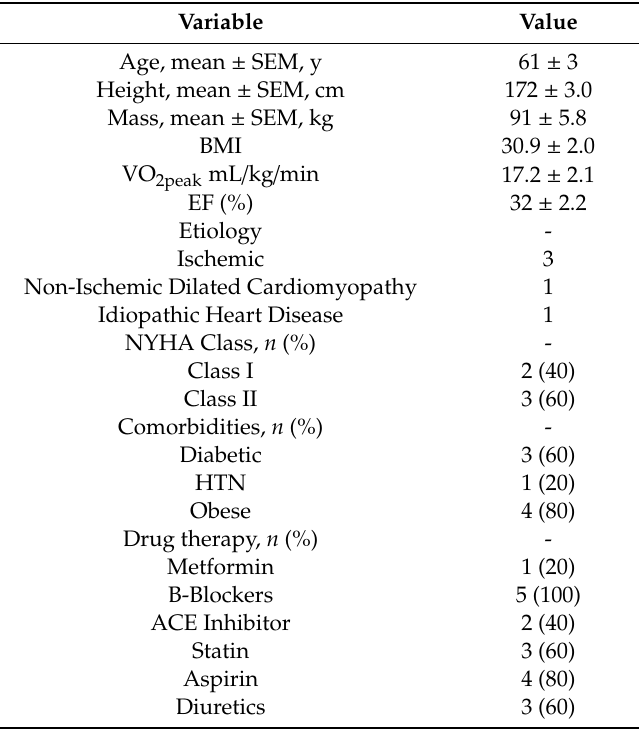
Table 1. Participant Demographics.